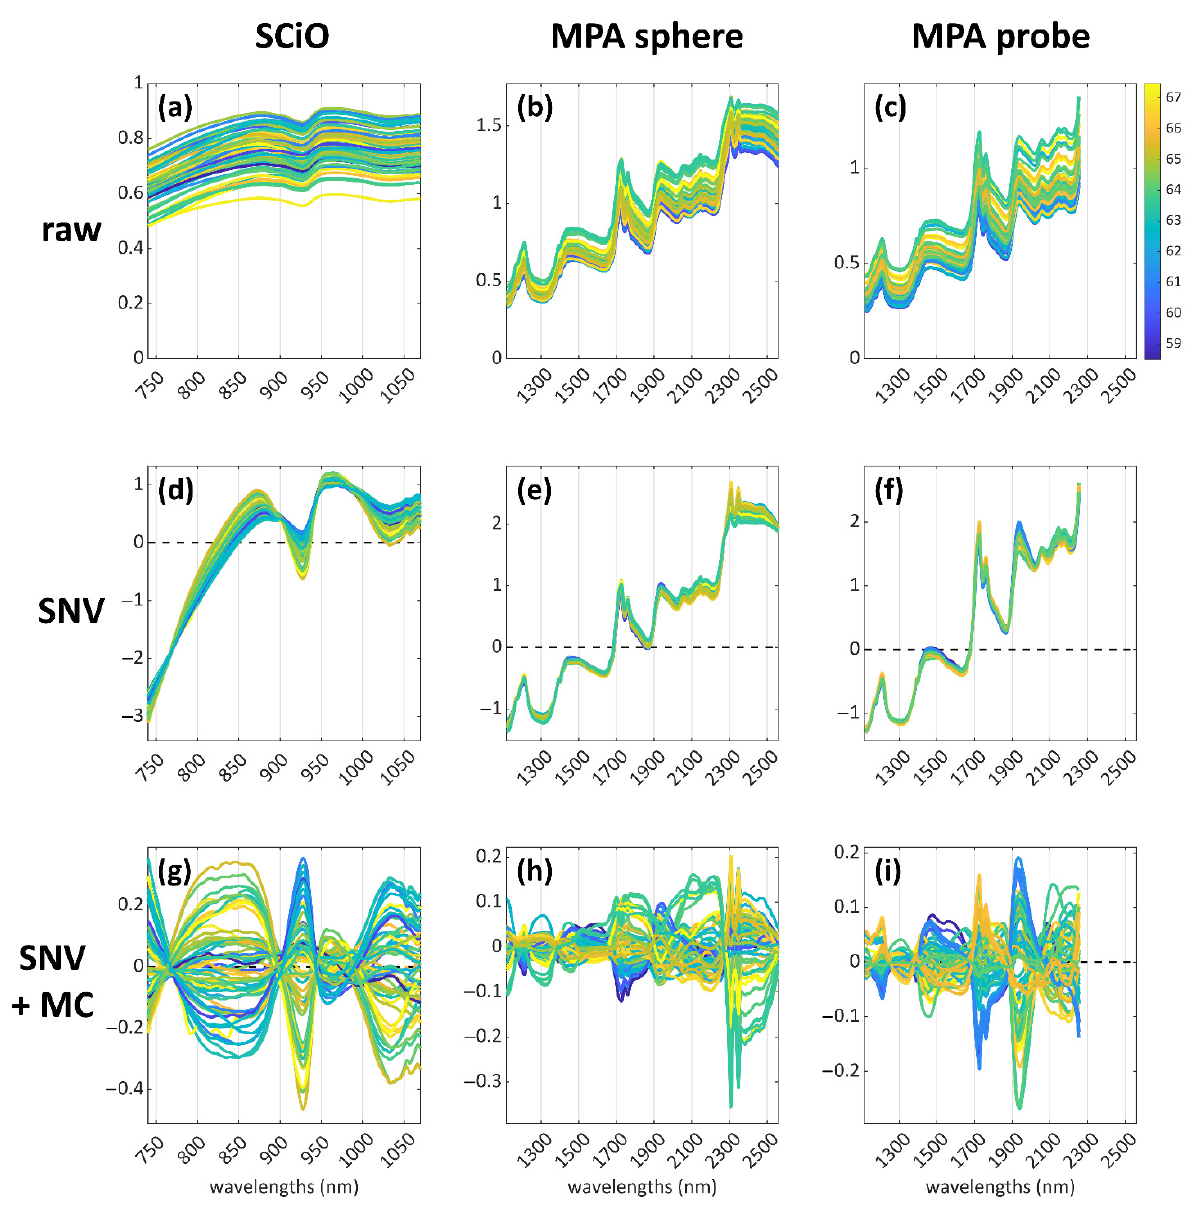
Figure 1. Visual representation of the data-preprocessing pipeline, declined, according to the three datasets (from top to bottom along each column): raw NIR spectra of the hazelnut samples ( a – c ); spectra preprocessed with Standard Normal Variate (SNV) ( d – f ); spectra preprocessed with SNV + mean centering (MC) ( g – i ).